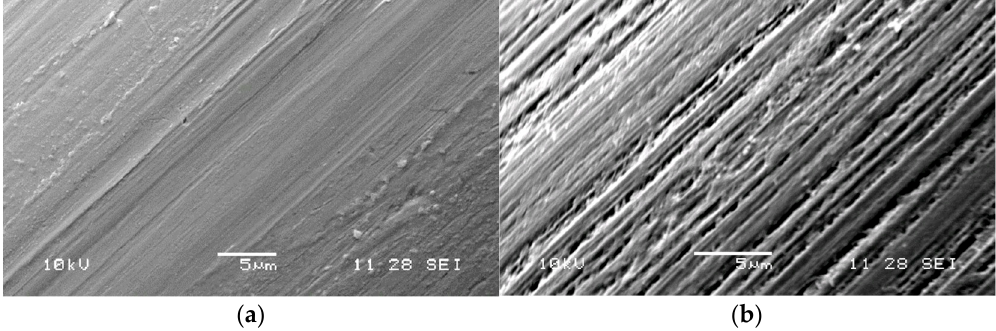
Figure 4. SEM images of the surface of high-strength micro steel fibres: ( a ) with and ( b ) without brass coating.